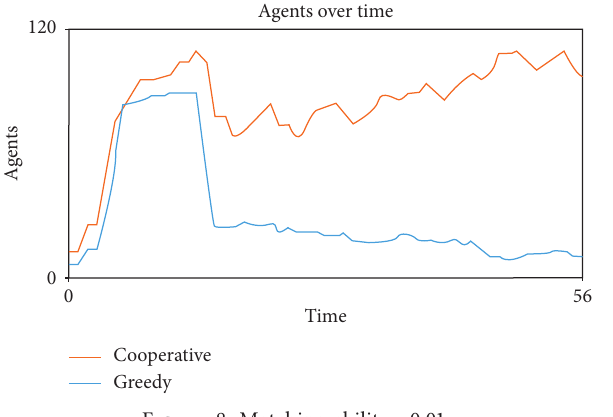
Figure 8: Matching ability �